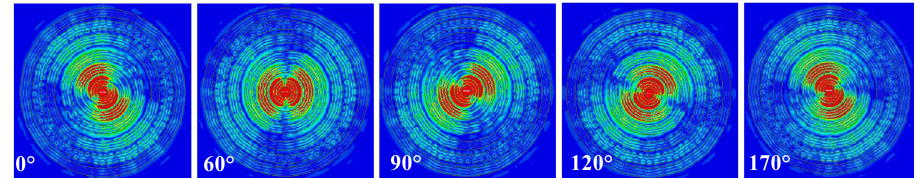
Figure 16. Electric field heat map for the CP source at different phases, the heat map scale is the same as in Fig. 8.